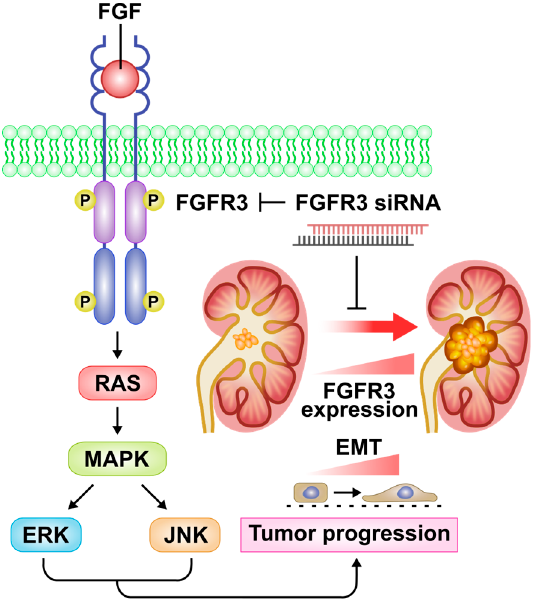
Figure 8. A mechanistic scheme depicting the effects of FGFR3 gene silencing on RAS/mitogen-activated protein kinase (MAPK) signaling and renal pelvis tumorigenesis. Upon stimulation by fibroblast growth factor (FGF), the intracellular tyrosine kinase domain of FGF receptor 3 (FGFR3) may deliver the mitogenic signal through RAS/MAPK cascade and downstream mediator activation, including extracellular signal-regulated kinase (ERK) and c-Jun N-terminal kinase (JNK). Hence, FGFR3 overexpression and activation may enhance expression of epithelial–mesenchymal transition (EMT) transcription factors and mediators, which eventually contribute to tumor progression. Our findings suggest that FGFR3 siRNA delivery is a useful strategy for alleviating the